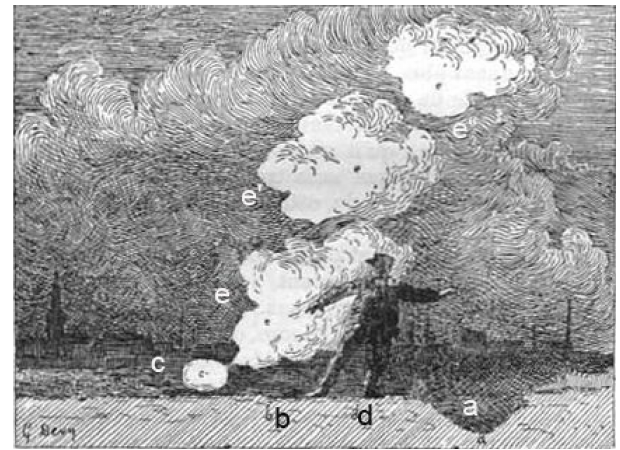
Figure 4. Figure 95 from Charcot (1895, p. 377) with German legend: “After a sketch of patient: a – the trench, b – the road, c – the luminous barrel, d – our sick one, e, e (cid:48) , e (cid:48)(cid:48) – the clouds of smoke”. Source: Engraving Fig. 95, Charcot (1889, p.